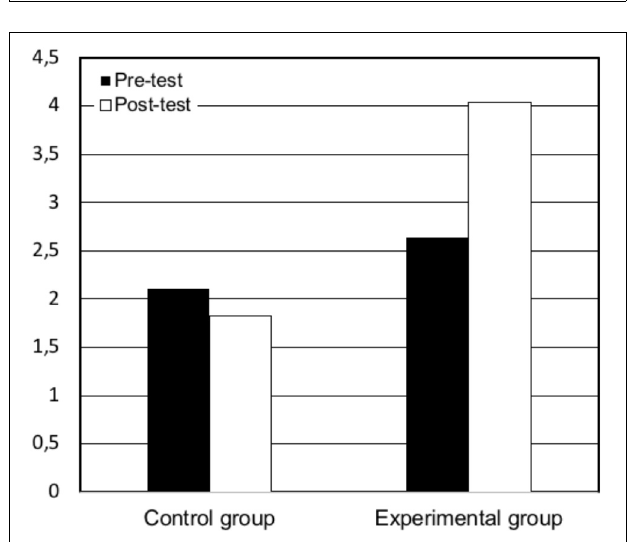
FIGURE 2 | Pre- and post-test mean of reference to critical memories by condition.